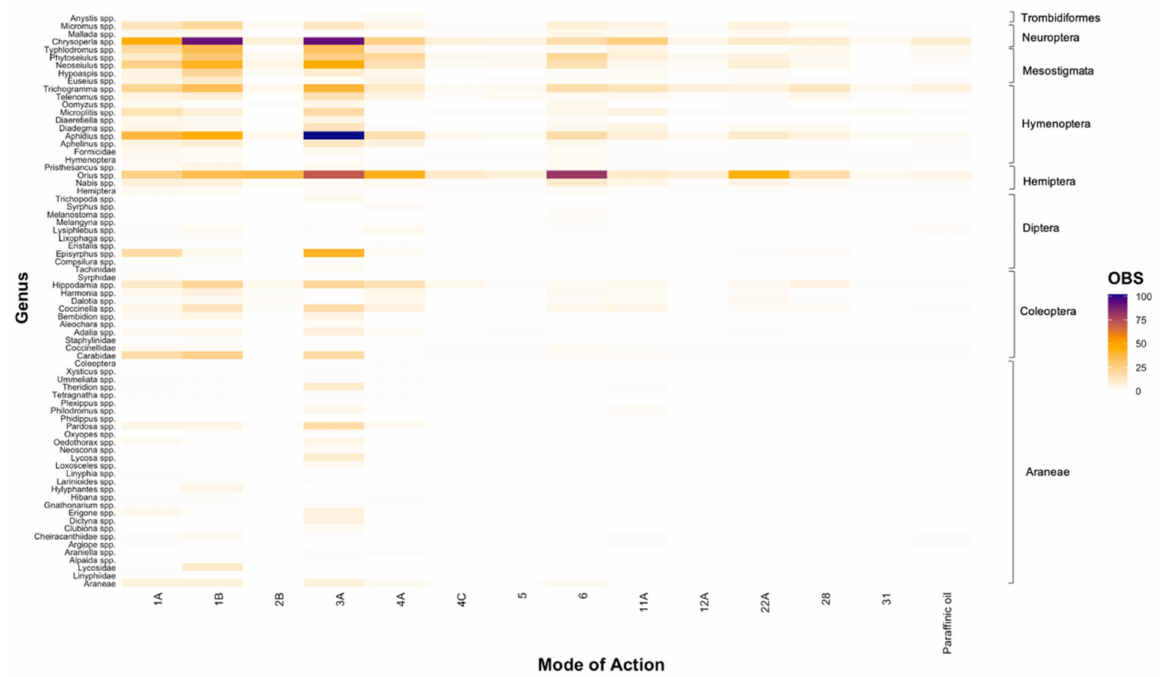
Figure 1. The number of entries (OBS) that tested the toxicity of chemical Modes of Action for natural enemy genera relevant to the Australian grains industry. Genera are grouped by order, which is illustrated on the right x-axis. Note: As some studies did not classify individuals tested to the genus level, some families (Carabidae, Coccinellidae, Formicidae, Linyphiidae, Lycosidae, Staphylinidae, Syrphidae, Tachinidae) and orders (Araneae, Coleoptera, Hemiptera, Hymenoptera) appear in the